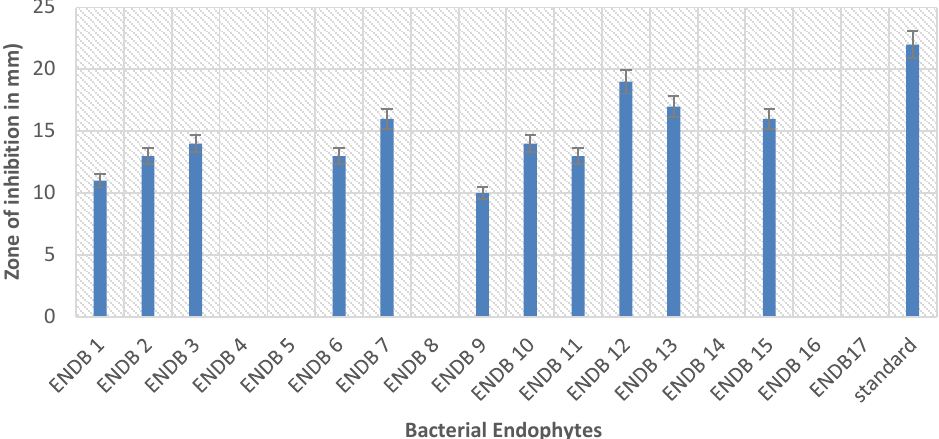
Figure 1. Antimicrobial potentiality spectra of bacterial endophytes against E. coli